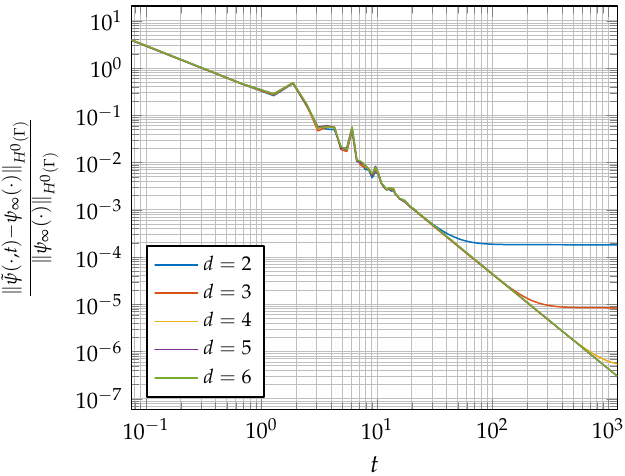
Figure 10. Time history of the relative error between transient and stationary solutions in H 0 ( Γ ) norm for increasing degrees of B-spline shape functions on a uniform spatial discretization of size ∆ α = π /10. The time interval [ 0,1200 ] is decomposed in 8000 time steps.